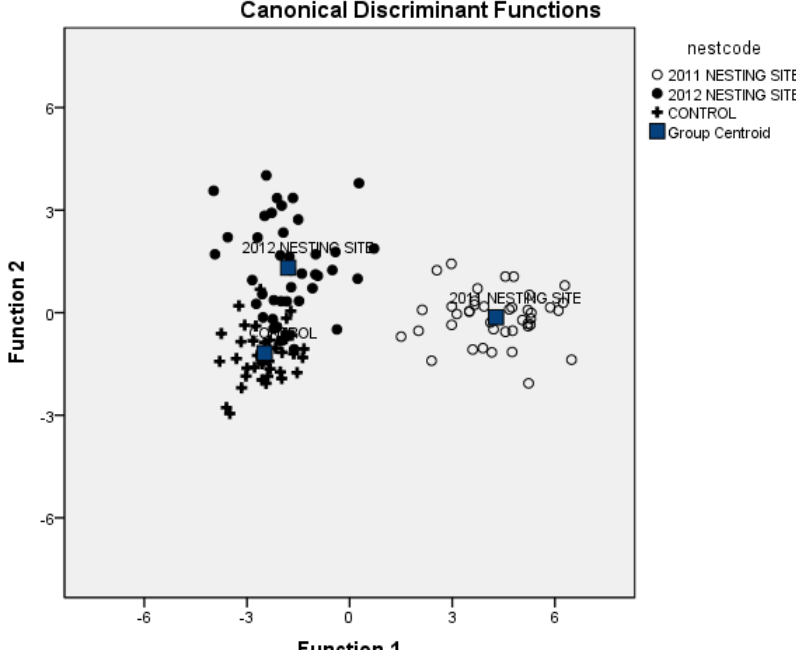
Figure 3. Canonical discriminant functions and their success in separating the 3 nesting sites (2011 nest, 2012 nest and control) for the significant vegetation and soil variables used by Socotra Cormorants in the